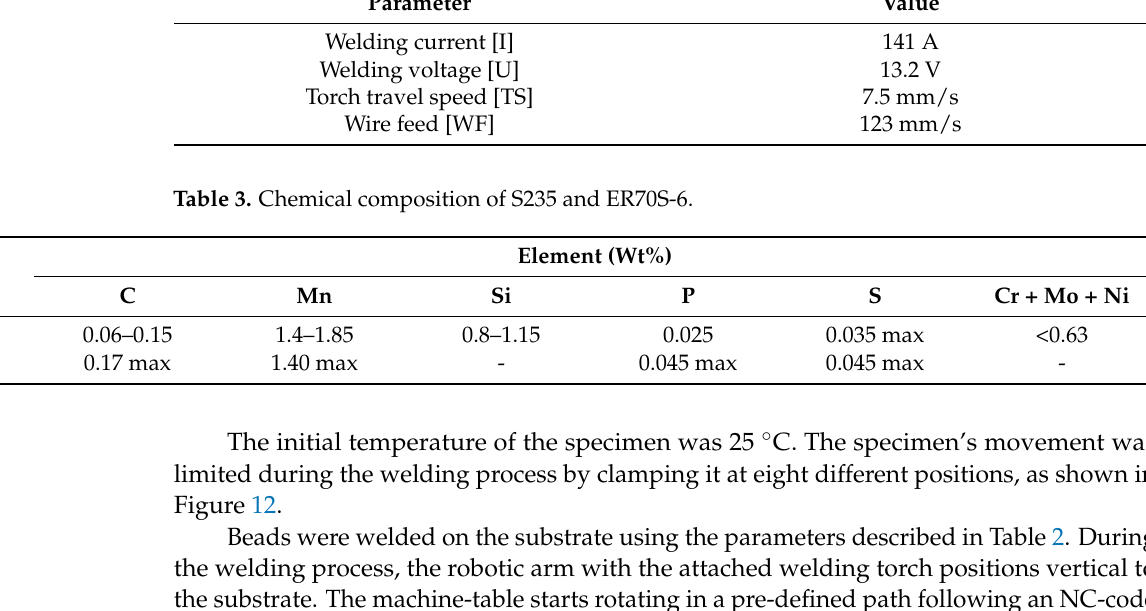
Table 3. Chemical composition of S235 and ER70S-6.